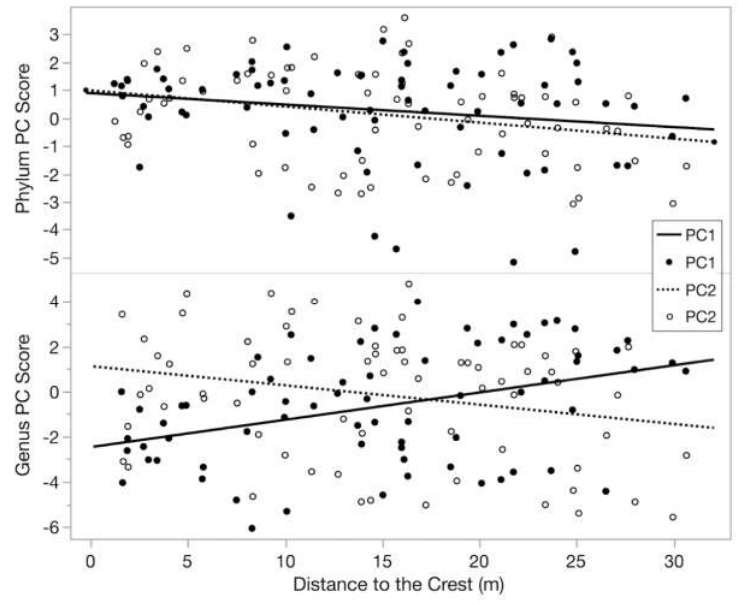
Figure 7. Genus and phylum spatial patterns using PC1 and PC2 scores from PCA analyses. Rela- tionships are significant except phylum PC1.